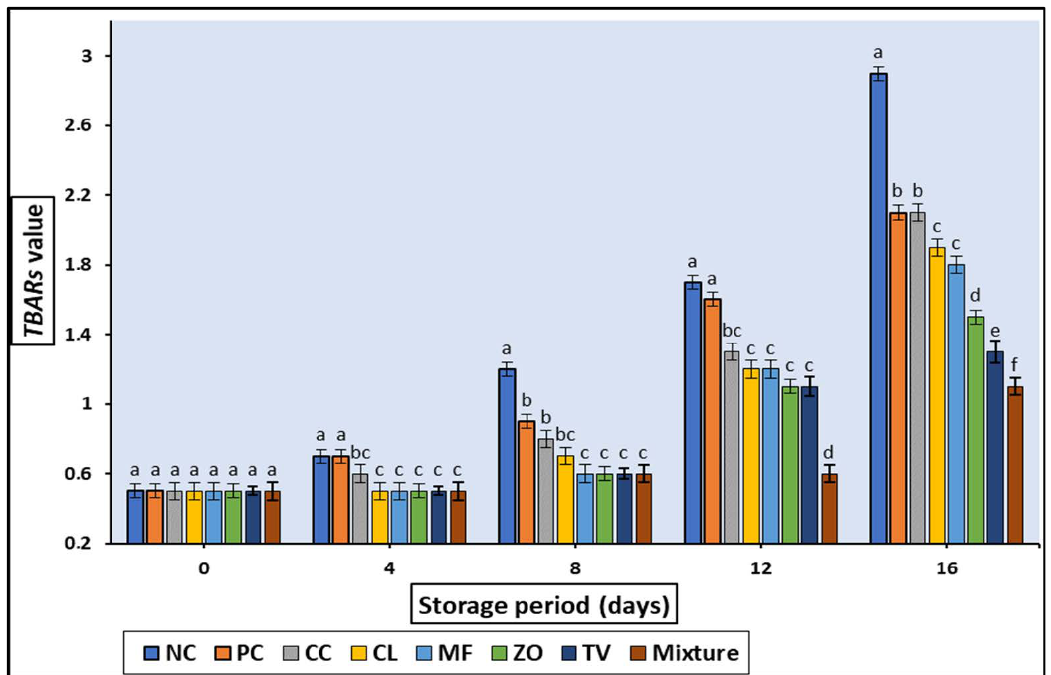
Figure 5. Effect of treating with different plant aqueous extracts on TBARs value of cold stored rabbit meat. Columns with different letters are significantly different ( p < 0.05).